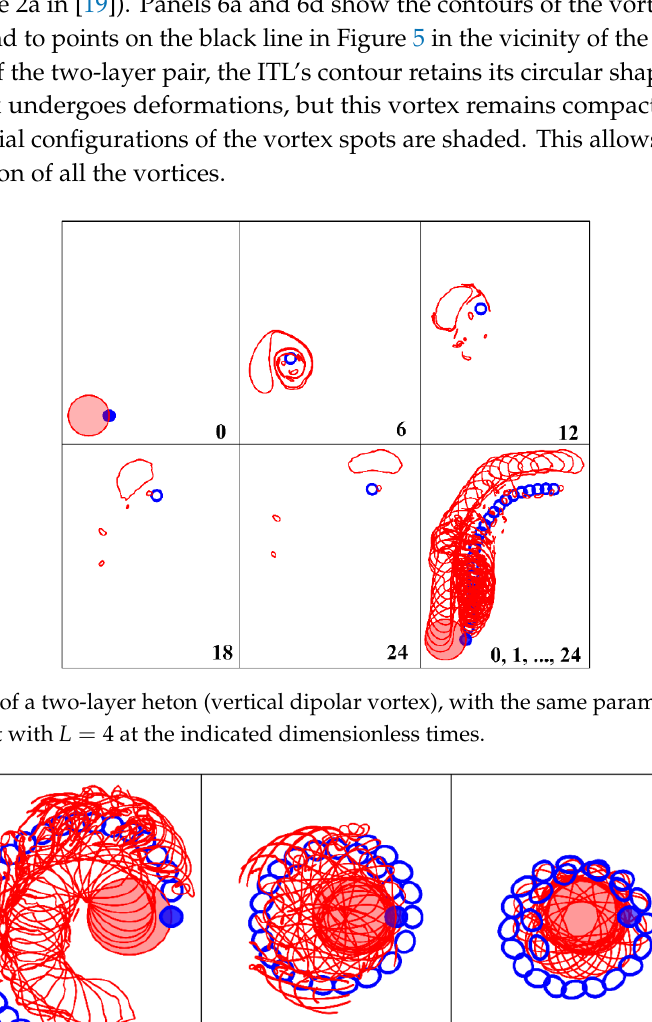
Figure 8. This figure is like the last panel of Figure 8 (for which 𝛲 2 = −0.6 ). Here we have ( a ) 𝛲 2 = −0.3, ( b ) 𝛲 2 = −0.15, ( c ) 𝛲 2 =